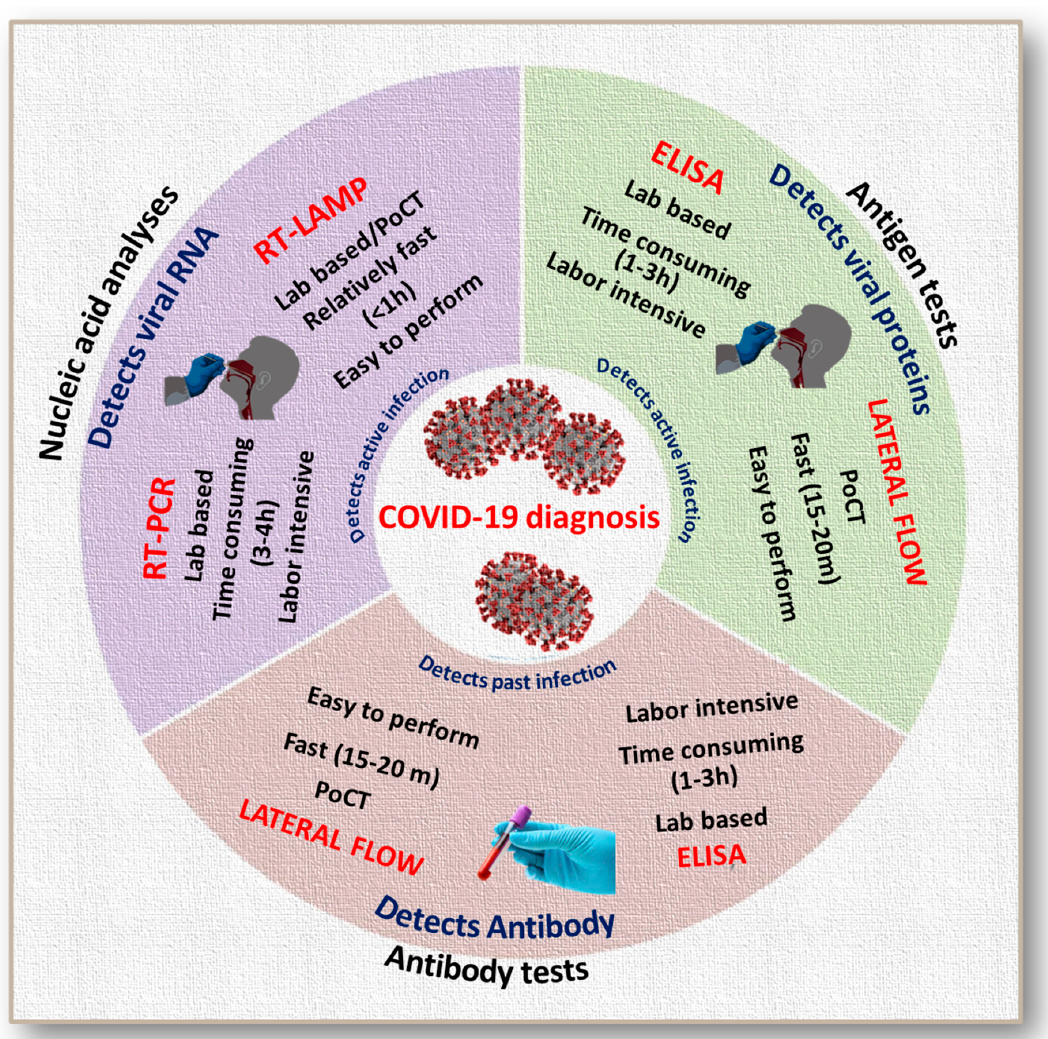
Figure 1. Scheme showing the comparison of di ff erent methods used for COVID-19 diagnosis (PoCT: Point of Care Test). Nucleic acid tests detect the genetic material from the virus. To collect the infected cells, a nasal or throat swab of the patient is required. Through a series of chemical reactions, copies of viral genetic material are produced. It helps to analyze whether or not a person has active infection. Polymerase chain reaction (RT-PCR) and Reverse Transcription Loop-Mediated Isothermal Amplification (RT-LAMP) are two major tests used in nucleic acid analysis. In total, 3–4 h are required to carry out RT-PCR. RT-LAMP is a simple method which can detect few copies of target nuclei sequences under isothermal conditions with the help of specially designed additional primer sets. It can be performed in laboratories or tested in point of care settings. RT-LAMP reaction can be completed within an hour. A rapid antigen test is a rapid diagnostic test which detects the presence of viral antigen usually in the nasopharyngeal samples. This is the newest method among the above described tests. In this type of test, chemicals fragment the virus and then antibodies attached to a plate detect these fragments. This provides relatively fast test results within 15 min. This again, helps to analyze whether or not a person has active infection. Lateral flow and enzyme-linked immunosorbent assays (ELISA) are the major types of antigen tests. Antibody tests help to detect past infections or those at advanced stages. Lateral flow test is the commonly accepted cost-e ff ective antibody test which does not require any specialized equipment. It is a relatively fast method of testing, completed within 15–20 min. This type of assay is performed on blood samples. ELISA is a laboratory-based antibody test which requires skilled professionals and is a time-consuming task of 1–3 h. By this method, up to 96 samples can be tested per